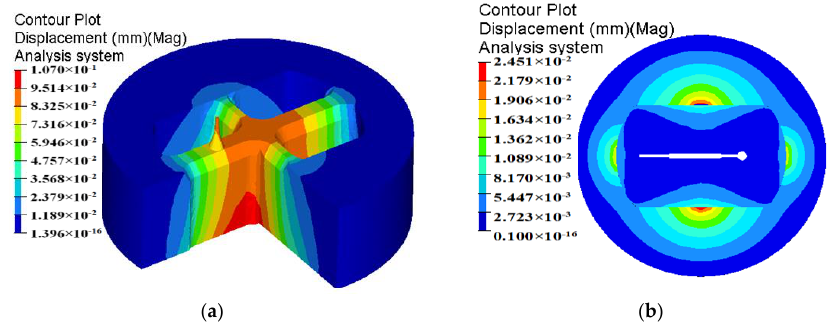
Figure 7. Displacement of the traditional designed die: ( a ) upper die and ( b ) lower die.